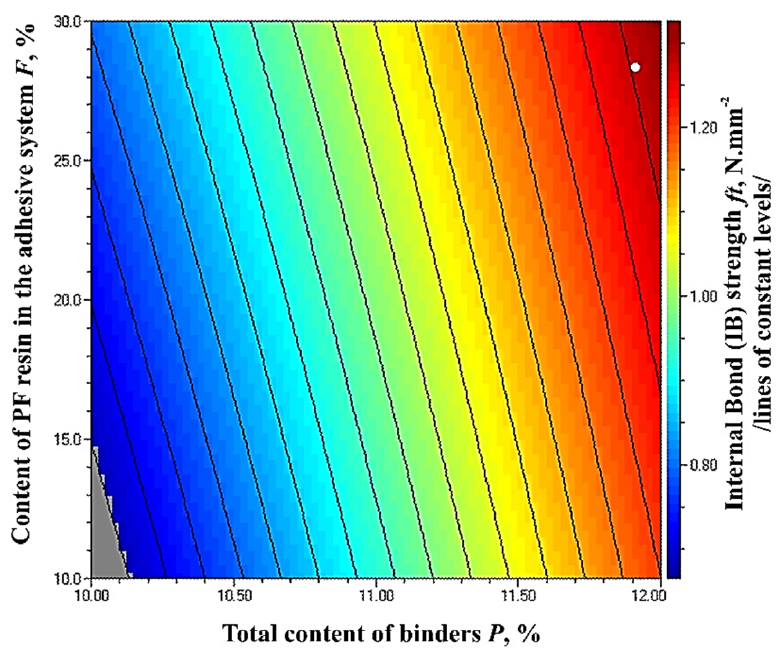
Figure 8. Effect of binder content and PF resin content in the adhesive system on the IB strength of fiberboard panels.